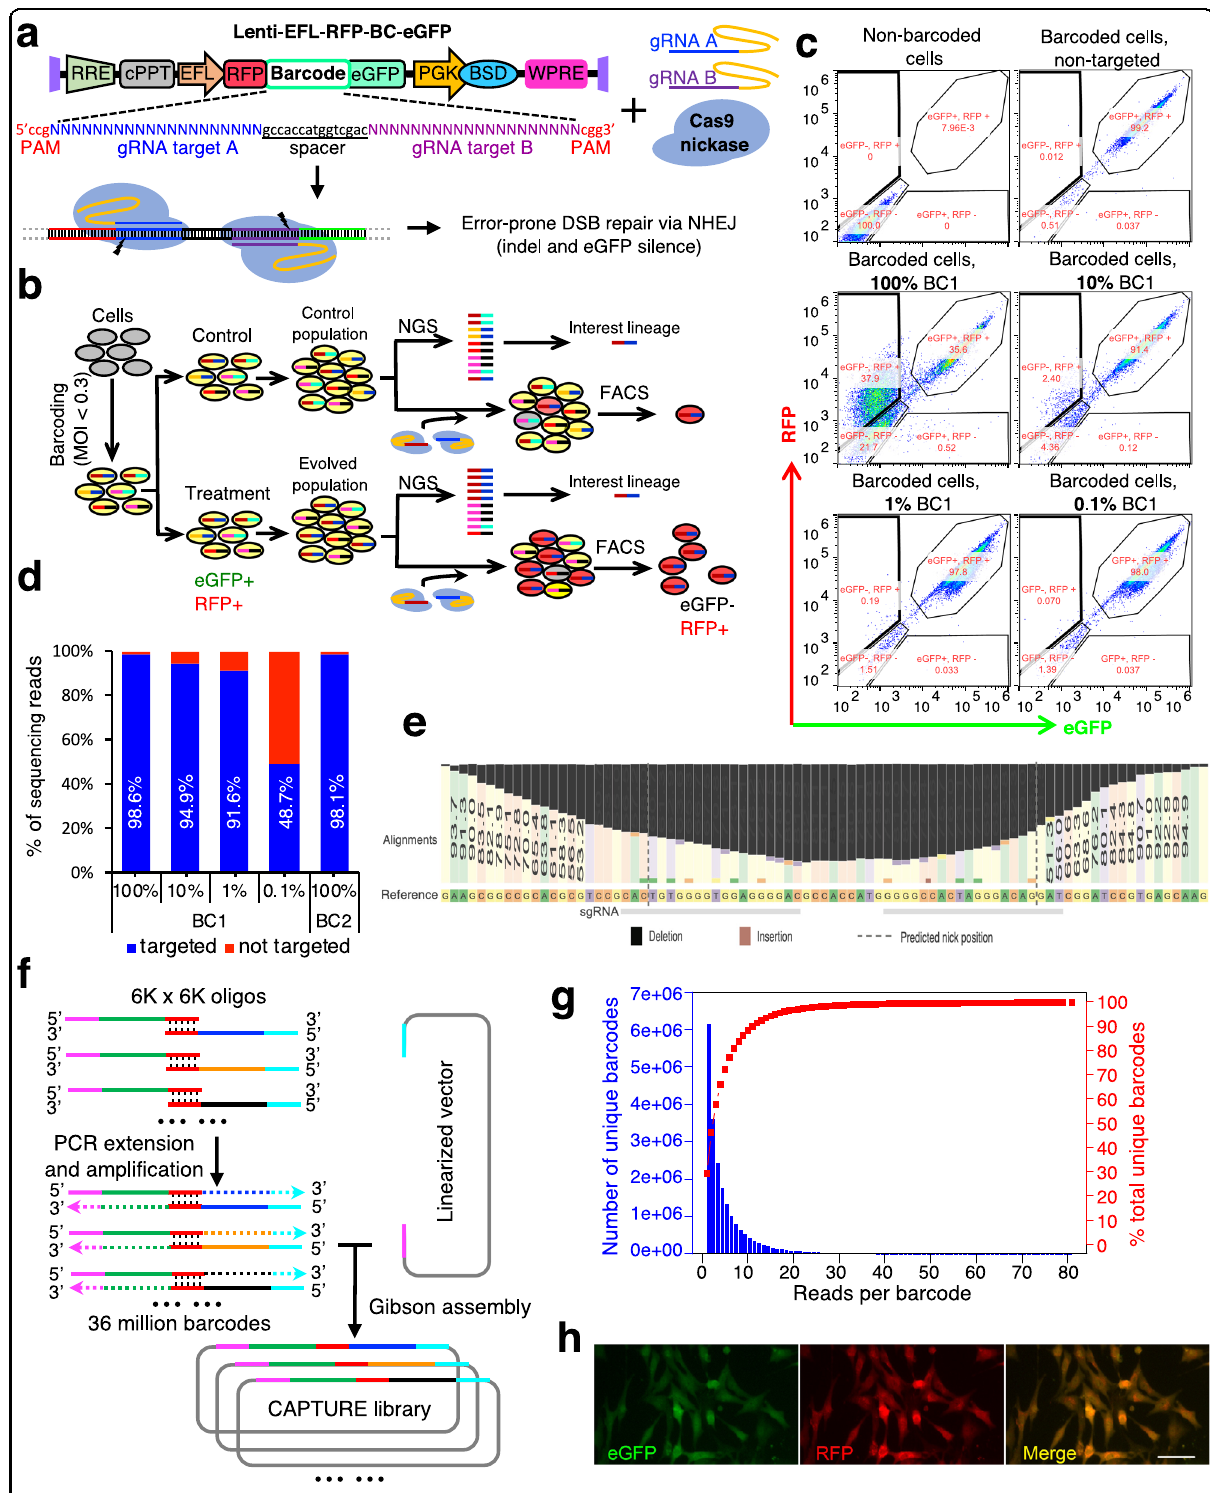
Fig. 1 (See legend on next